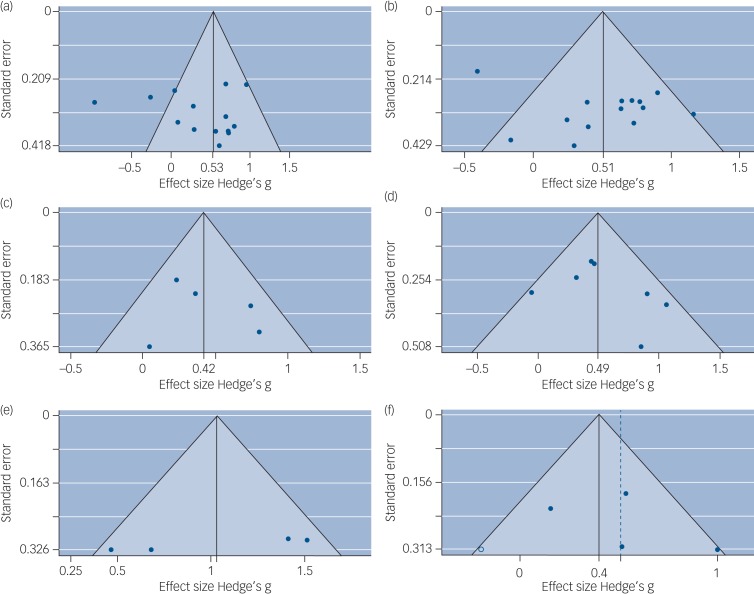
Funnel plots by cognitive domain.